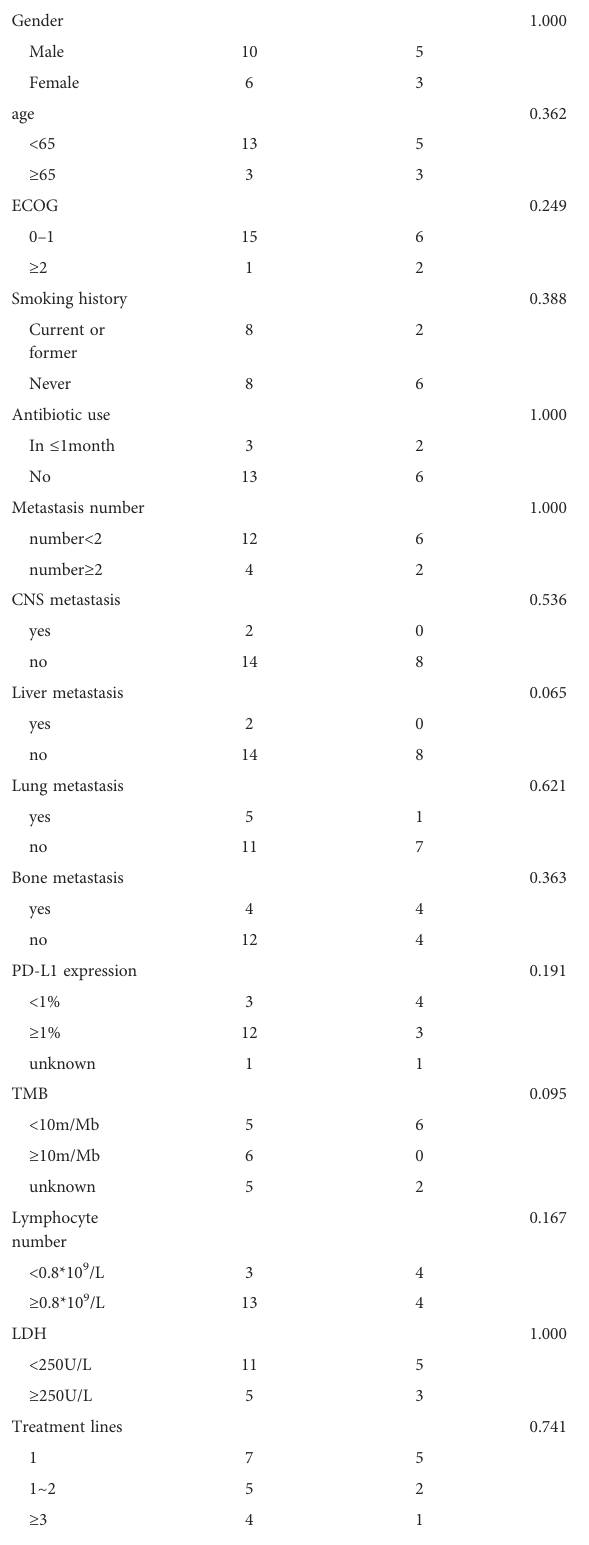
TABLE 1 Clinical data of patients in the R and NR